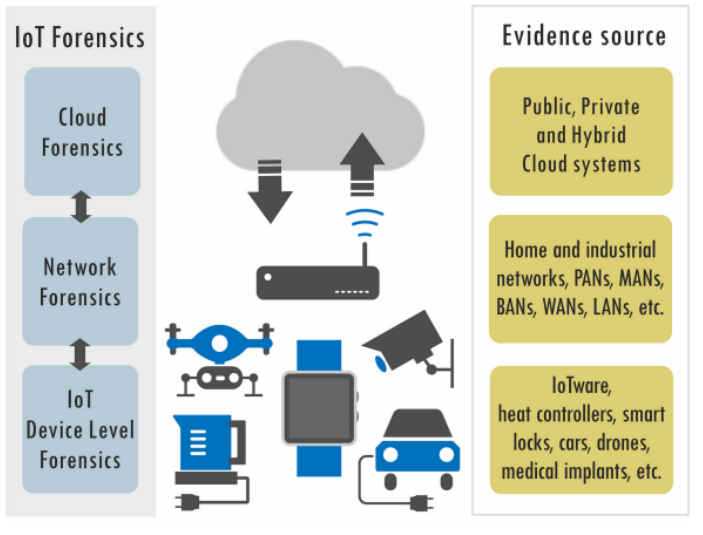
Figure 4. The components of IoT forensics